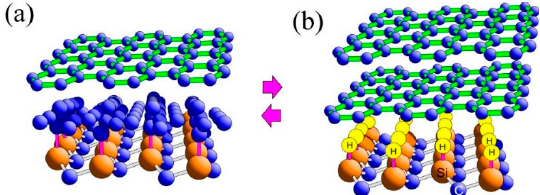
Figure 19. ( a ) A sketch of monolayer graphene on the SiC(0001) substrate including a strongly bound buffer layer at the interface. ( b ) The structural model of new phase formed, having a hydrogen intercalated layer in between the SiC substrate and the initial buffer layer which has now become the second graphene layer [112].